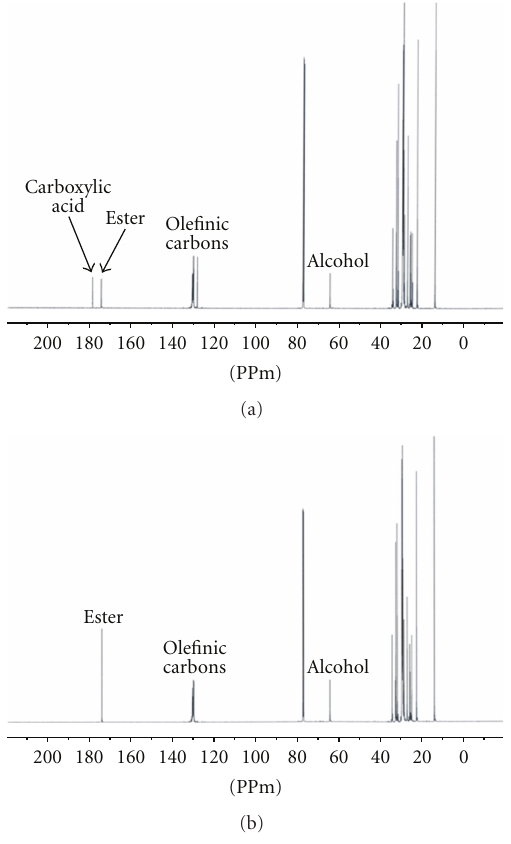
Figure 5: 13 C NMR spectrum of HYOOA (a) and OLHYOOD (b).